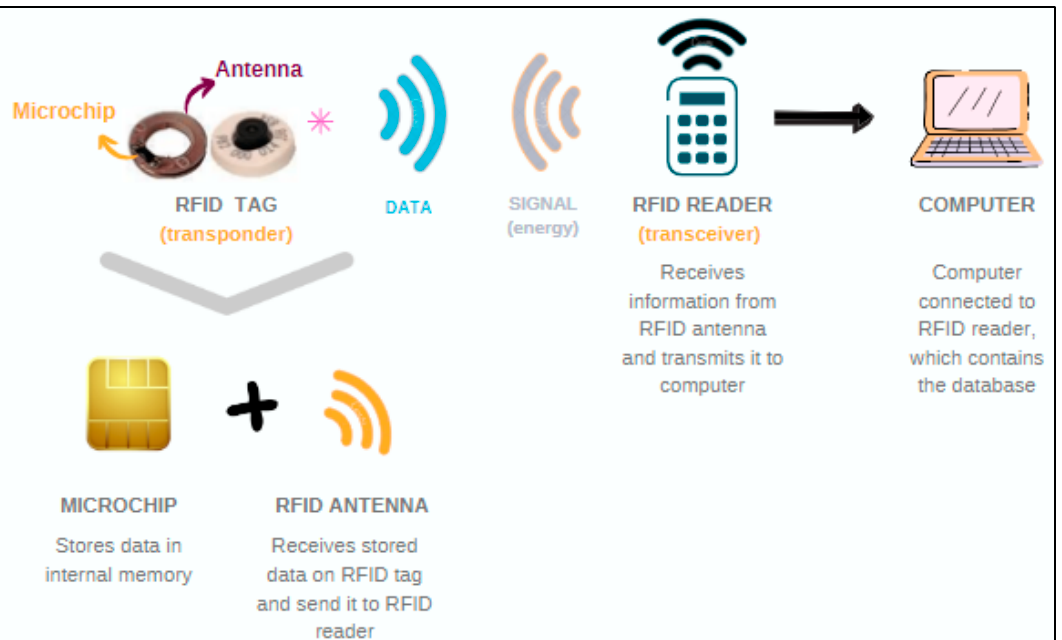
Figure 2. Basic electronic identification (EID) using radiofrequency identification system (RFID) transmission. Note that the RFID tag can have different presentations. This figure shows an example of an electronic ear tag. * Could also be a collar or a pedometer as a transponder. Own source.